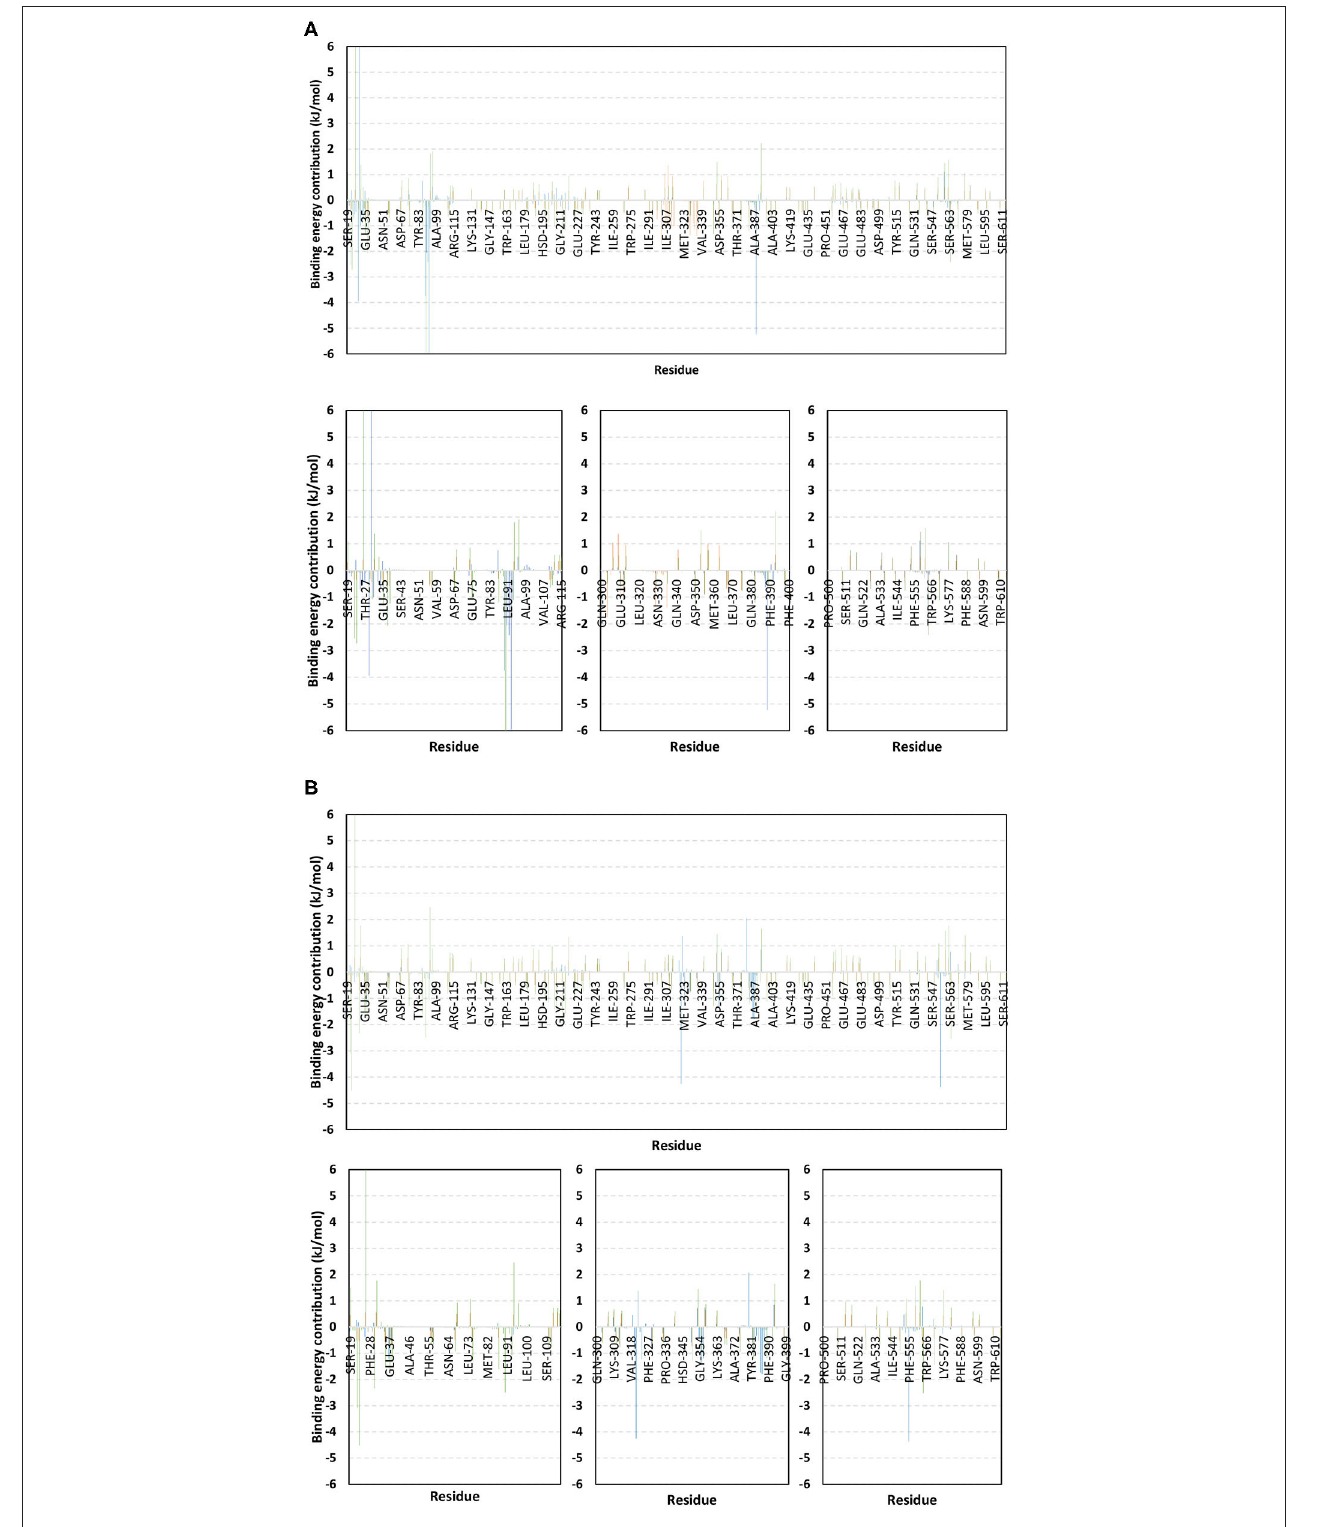
FIGURE 10 | Binding-free energy/residue decomposition illustrating the protein residue contribution at alacepril- h ACE2 protein complex 1 G binding calculation. The residue-wise energy contributions across (A) 30–70 ns and (B) 80–100 ns MD simulation timeframes were represented in blue, brown, and green colored bars for alacepril, lisinopril, and NAG, respectively. Lower panels are expanded versions of three designated residue regions (19–115, 300–400, and 500–614) of the upper panels.